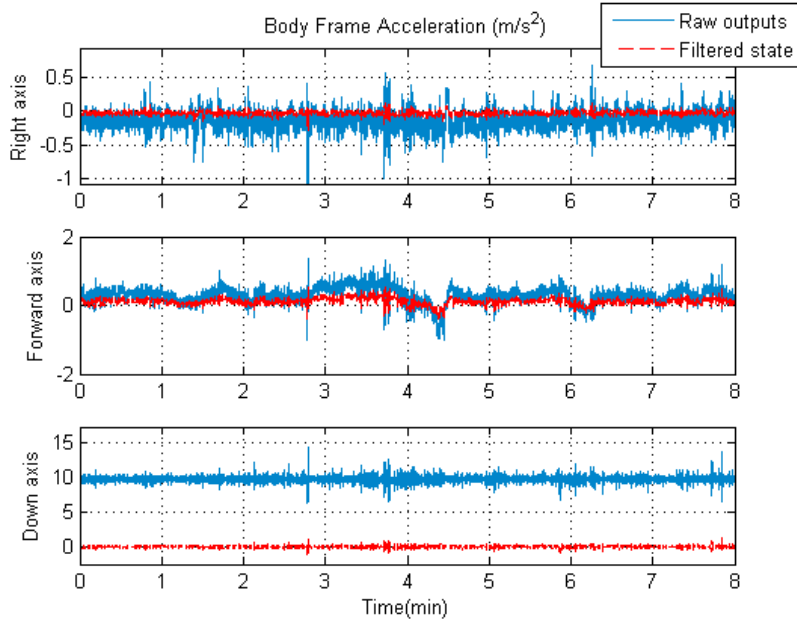
Figure 8. The raw specific force of the central IMU and the filtered acceleration.